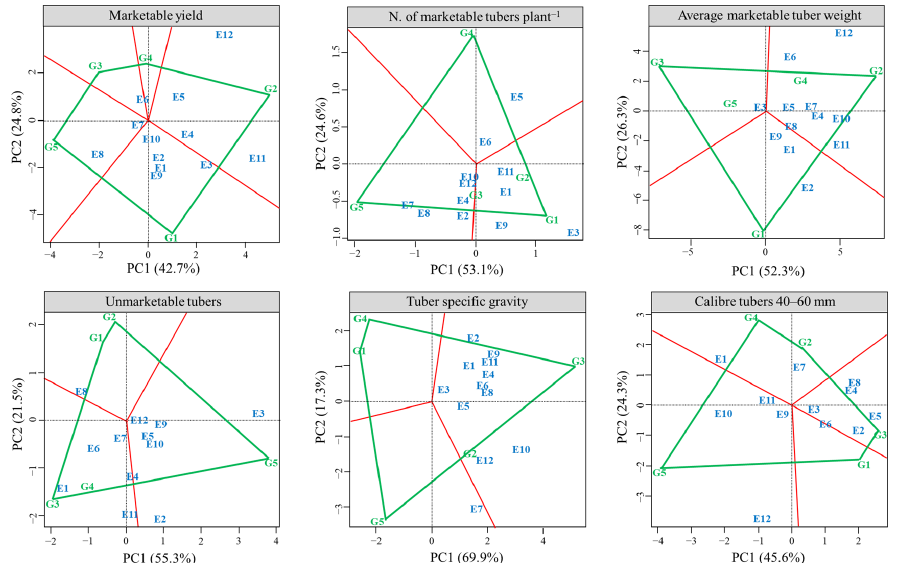
Figure 4. Polygon view of the GGE biplot illustrating the “which-won-where” analysis of five potato genotypes (G) over 12 environments (E). The biplots were constructed with scaling = 0, centering = 2, and SVP = 2. G1: Arizona; G2: Generosa; G3: Levante; G4: Paradiso; G5: Vogue; E1–E4: Acireale (seasons I to IV); E5–E8: Giarre (seasons I to IV); E9–E12: Mascali (seasons I to